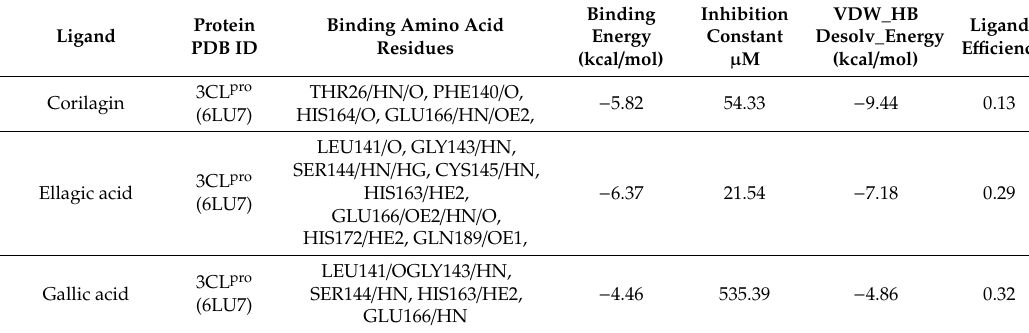
Figure 2. The docking mode of polyphenols present in Geranii Herba ( Geraniaceae ) with 3C-like proteinase (3CL pro ). ( a ) The 9 polyphenols retained in the cavity of the surface region of 3CL pro . ( b ) Ellagic acid. ( c ) Geraniin. ( d ) Quercetin. ( e ) Corilagin. ( f ) Kaempferitrin. ( g ) Protocatechuic acid. ( h ) Gallic acid. ( i ) Kaempferol. ( j ) Kaempferol 7- O -rhamnoside. Table 3. The binding details of polyphenols present in Geranii Herba ( Geraniaceae ) with 3C-like proteinase (3CL pro